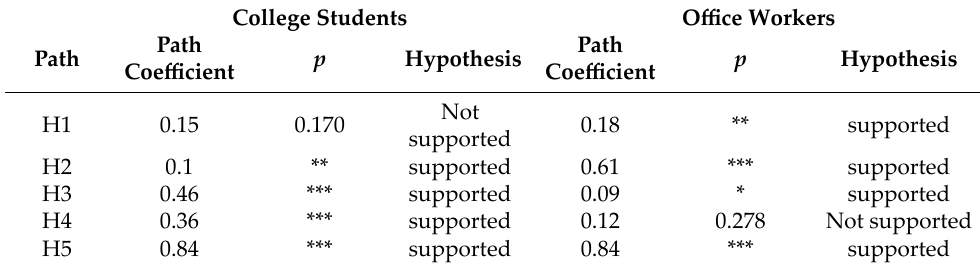
Table 5. Hypothesis test